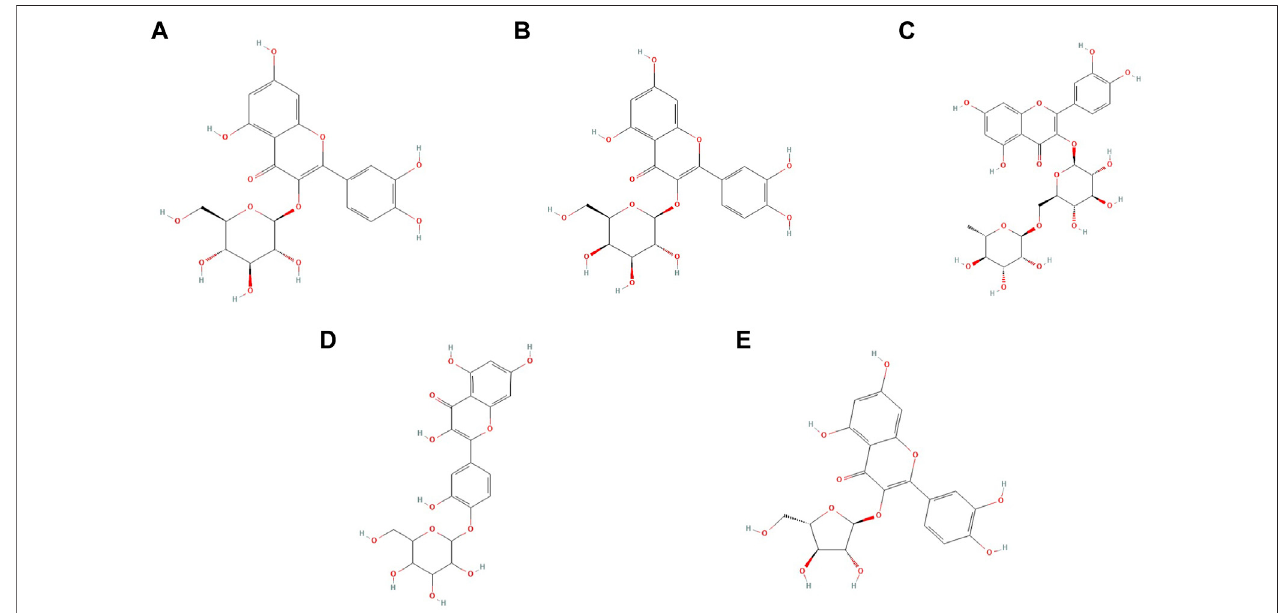
FIGURE 2 | Chemical structures of quercetin glycoside derivatives: (A) isoquercetin; (B) hyperin; (C) rutin; (D) quercetin; 4 ′ -O-glucoside; (E) quercetin-3- α - L